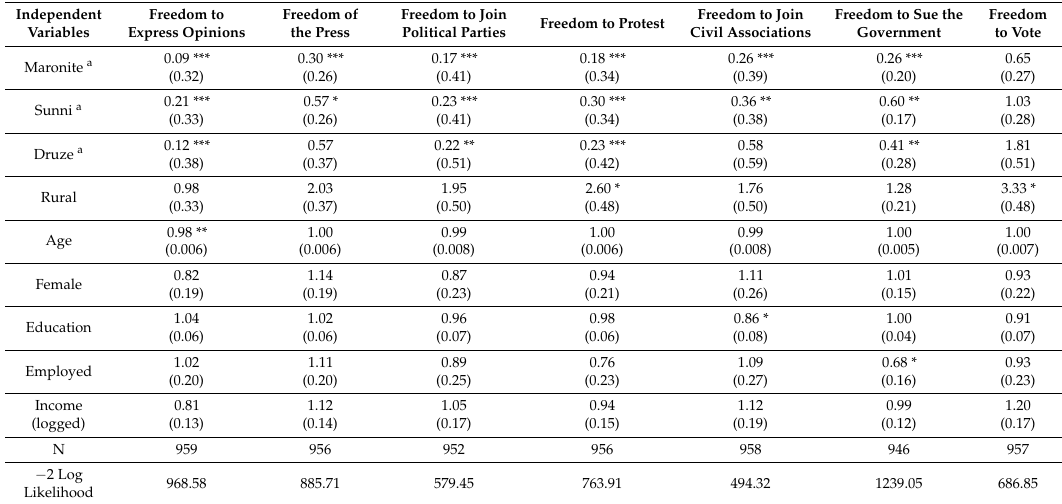
Table 9. Estimated Odds Ratios for Perceptions of Freedom in